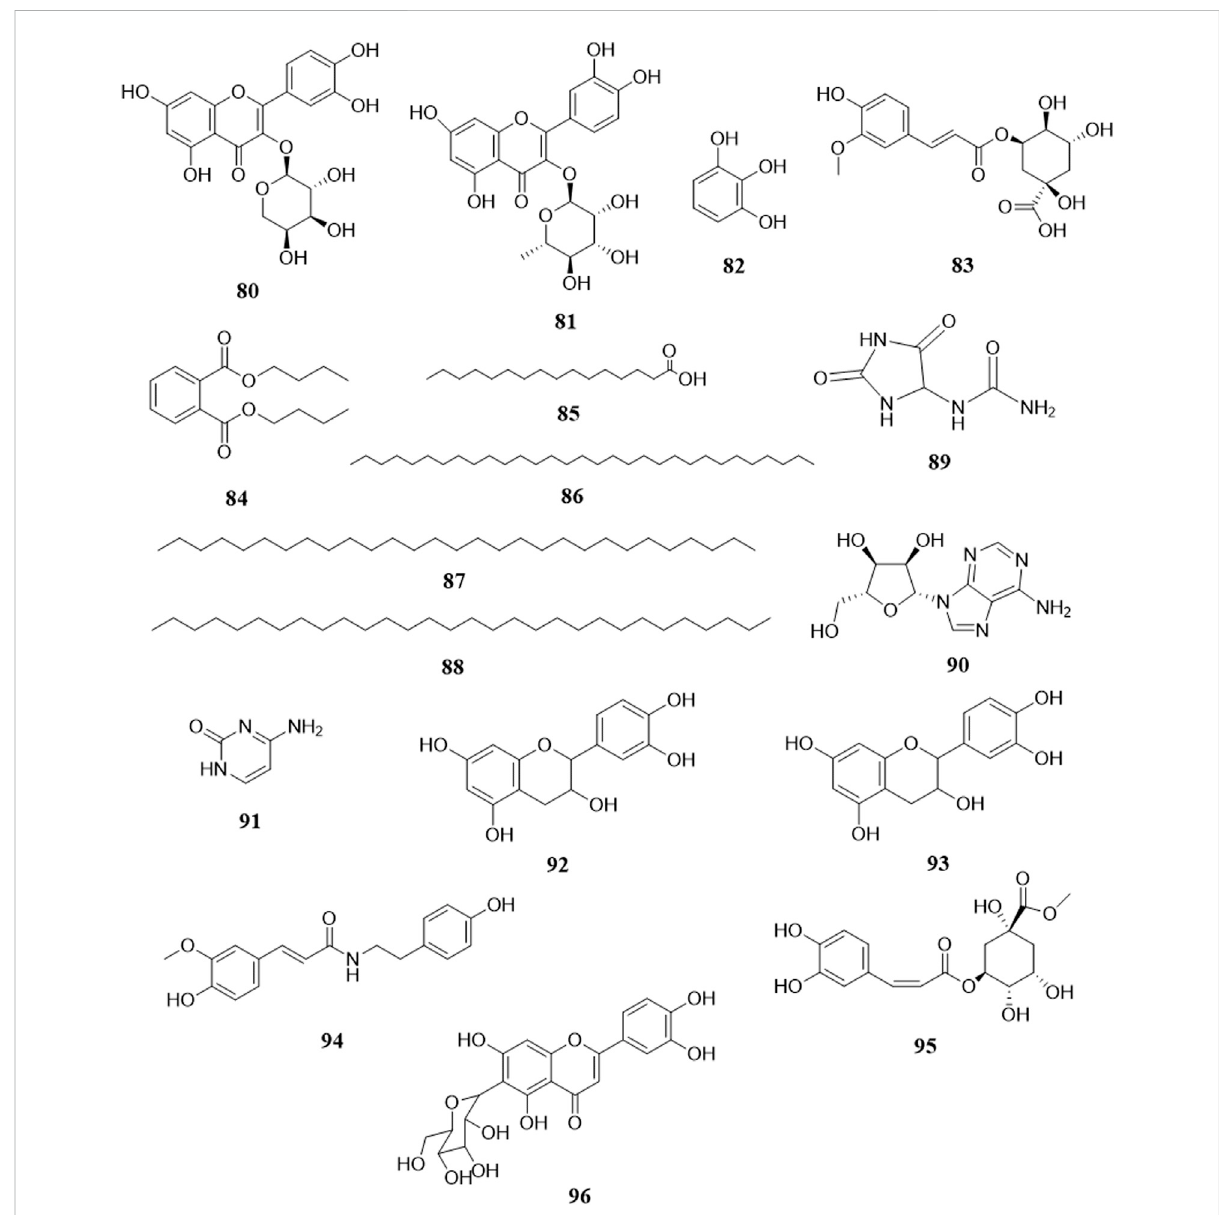
FIGURE 8 Structure of other compounds from Bolbostemma paniculatum (Maxim.)